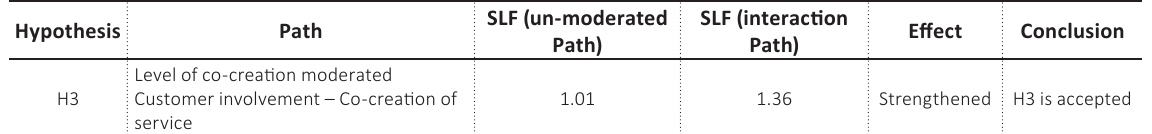
Table 5. Path coefficient moderated effect Hypothesis